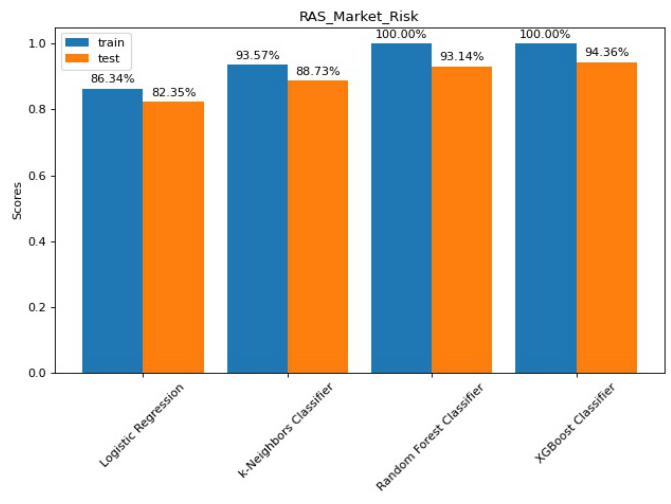
Figure 5. F1-scores of each model, using train-test split